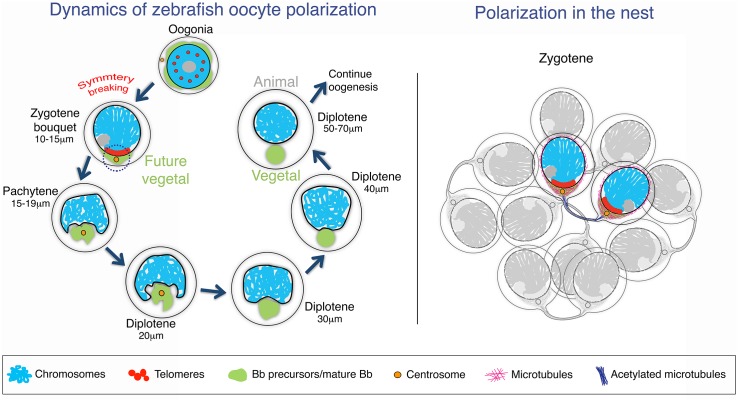
Dynamics of zebrafish oocyte polarization.(A) Oocyte symmetry breaking model and early Bb formation. In the premeiotic oogonia, Bb precursors are distributed radially in the cytoplasm, telomeres are scattered intranuclearly, and the centrosome is at a perinuclear position. Nuclear and cytoplasmic asymmetry is first evident when meiosis initiates, and the centrosome and the telomere cluster form the meiotic—vegetal center (circled by a dashed line) during zygotene stages. Bb precursors transition to the cytoplasm localized around the centrosome and adjacent to the telomere cluster of the zygotene bouquet configuration. At this stage the nuclear axis of the bouquet configuration predicts the animal—vegetal cellular axis of the oocyte, with the telomere cluster and the centrosome marking the future vegetal pole. At the subsequent pachytene stage, the nuclear cleft forms at the position of the centrosome where the Bb precursor components also aggregate. The nuclear cleft is most pronounced at the onset of diplotene (20 μm). Throughout pachytene and early diplotene (17–25 μm), the centrosome is found at the center of the Bb precursor aggregate and the cleft. During the following diplotene stages, the nuclear cleft gradually rounds out and the mature, spherical Bb forms, marking the definitive vegetal pole in the oocyte. (B) Model for polarization in the cyst. Oogonia in the cyst are connected by cytoplasmic bridges due to incomplete cytokinesis. With the onset of meiosis, specialized acetylated tubulin cables may connect sister oocyte pairs through the cytoplasmic bridges of the last mitotic oogonial division (a highlighted pair is shown). The division plane of the mitotic oogonia therefore positions the centrosome and the future meiotic—vegetal center at zygotene. While the polarity axis may be preset in the mitotic oogonia, polarization is only active at the onset of meiosis, when symmetry is in effect broken.